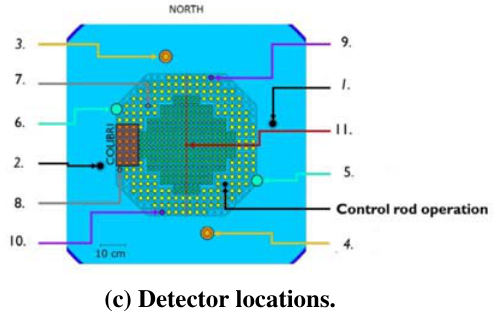
Figure 1: The CROCUS reactor & the experimental setup.